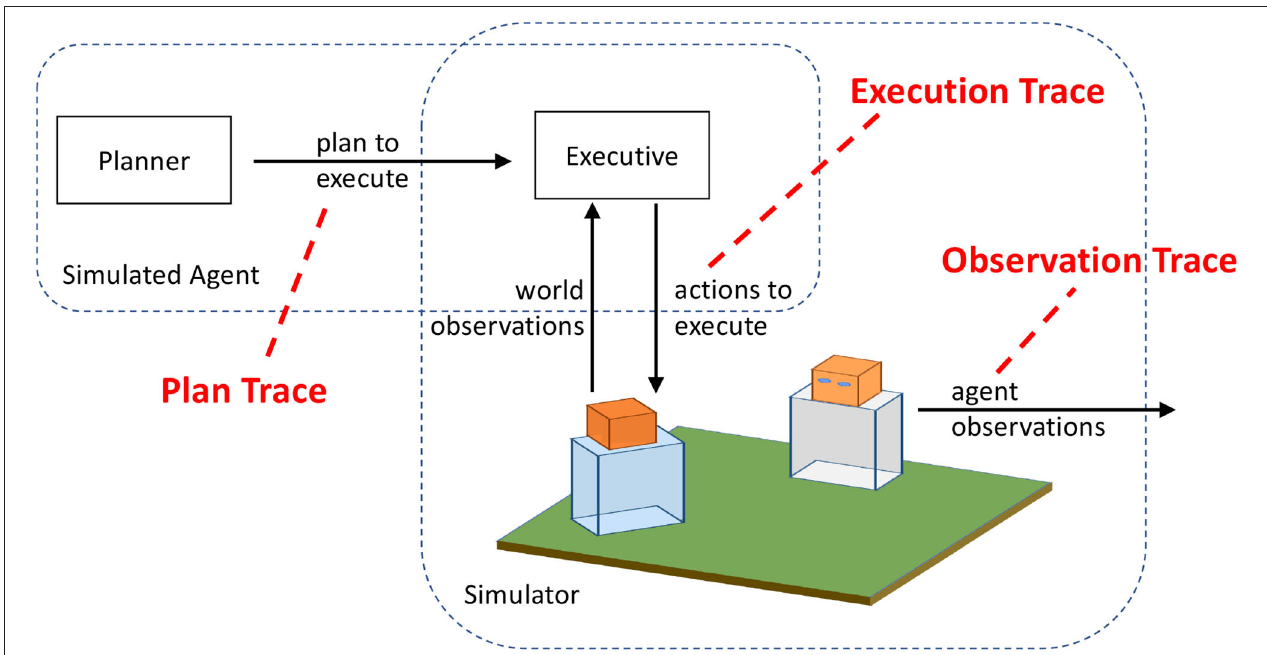
FIGURE 3 | Three types of traces provide three levels of